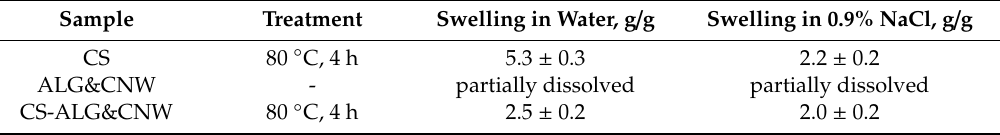
Figure 5. X-ray di ff raction patterns: CNW (1), ALG-film (2), ALG&CNW-nonwoven (3), and CS–ALG&CNW-nonwoven (4). Table 2. Swelling of nonwoven materials (mean ± SD, n =